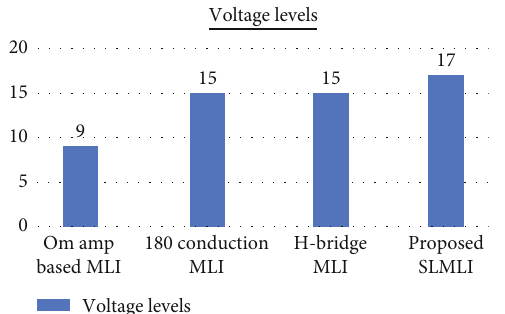
Figure 41: Comparison between numbers of voltage levels.